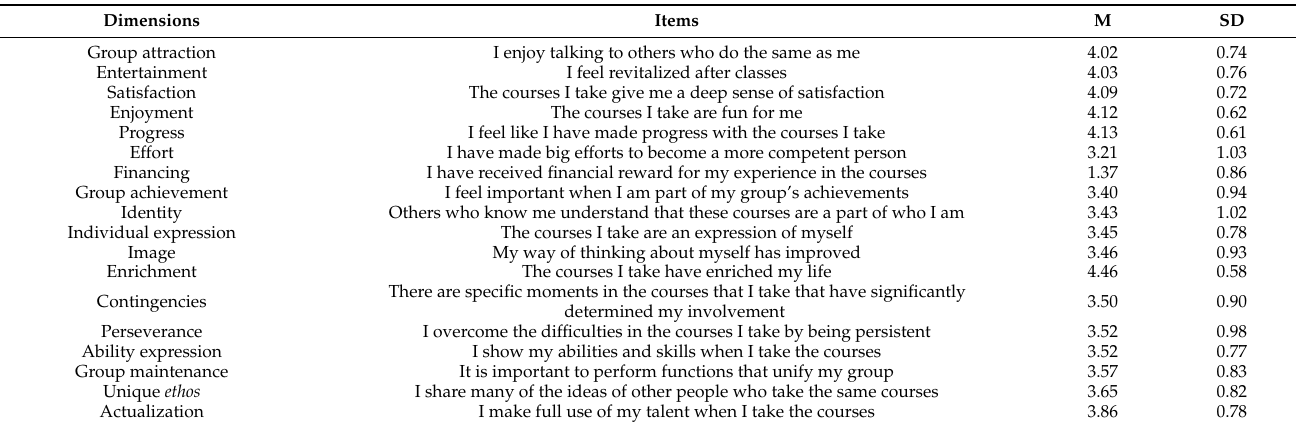
Table 2. Mean and standard deviation for Serious Leisure